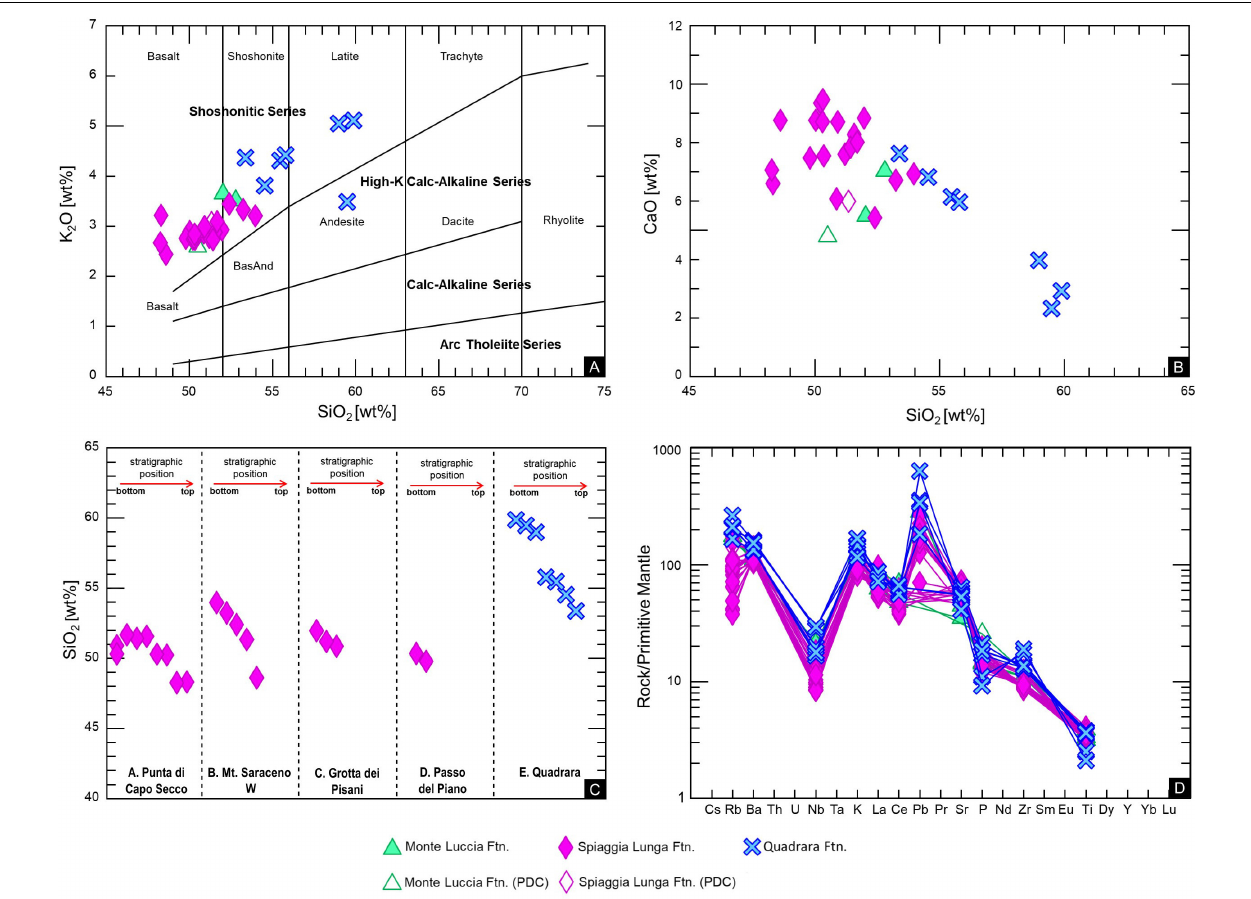
FIGURE 6 | Whole rock diagrams for the collected rock samples. (A) Peccerillo and Taylor (1976) classificative diagram; (B) CaO vs. SiO 2 variation; (C) variation of SiO 2 content with stratigraphic height in the different sampled outcrops; (D) primordial mantle- normalized (Sun and McDonough, 1989) spider diagram of incompatible elements